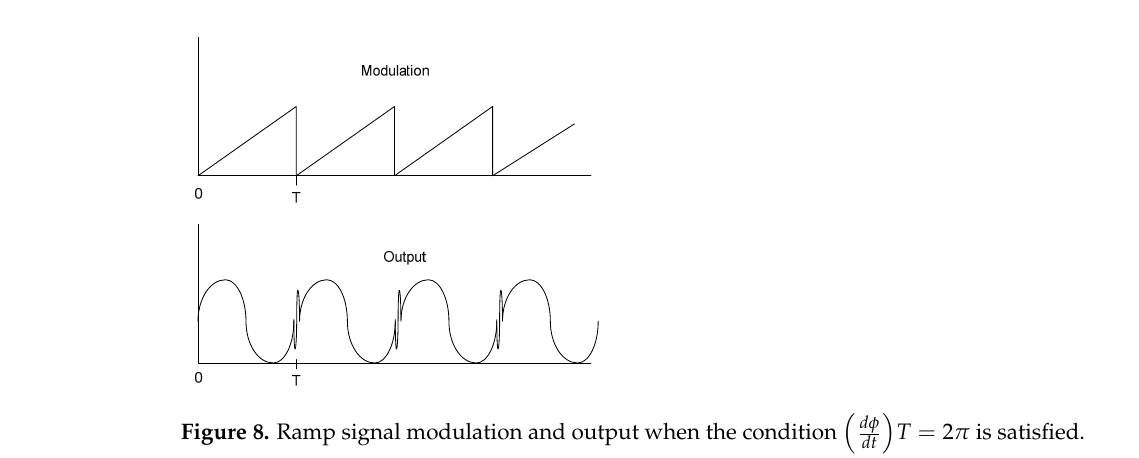
Figure 8. Ramp signal modulation and output when the condition